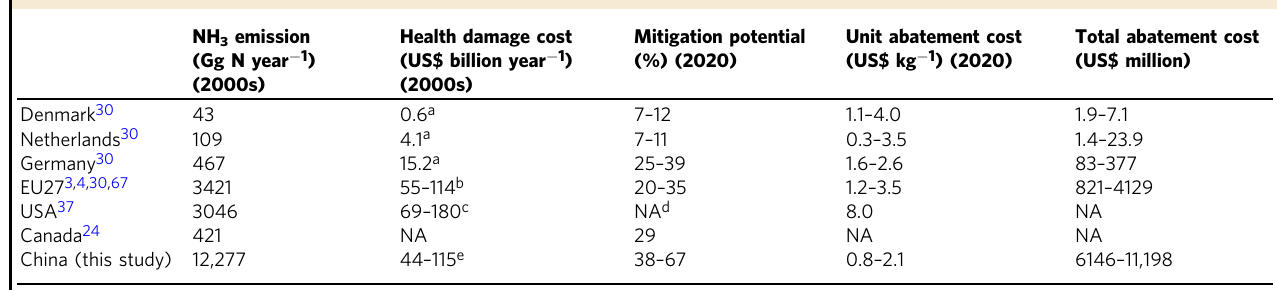
Table 1 NH 3 mitigation potential and costs in different